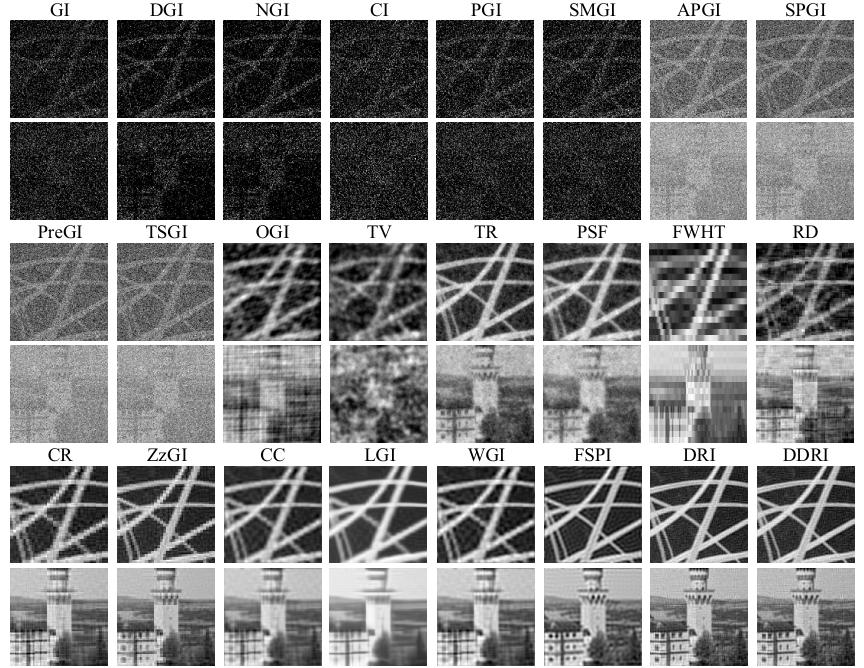
Figure 3. Simulation results of twenty-four methods without WGN. The results are obtained in ideal environment (without any noises).